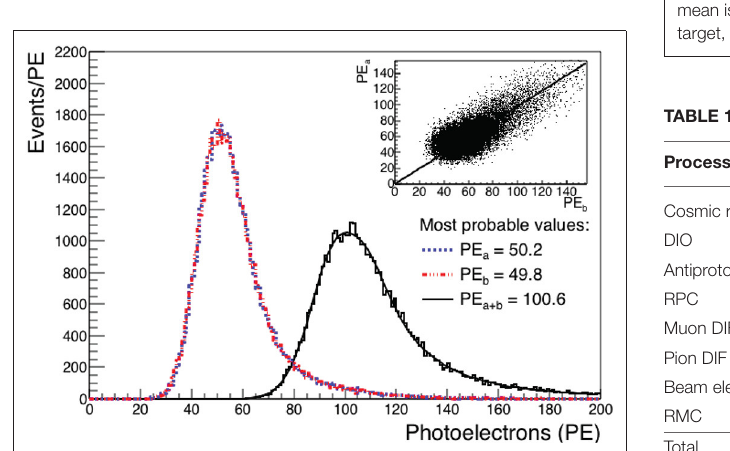
FIGURE 18 | Response in photoelectrons at a position 1 m from the SiPM readout for the reference counter read out with 2 × 2 mm 2 SiPMs. Dashed and dotted curves are the respective responses from each of the two SiPMs at one end of the counter, and the solid line is the sum of the responses. The distribution was fit to the sum of a Gaussian and a Landau function and the fit is also shown for the summed response. The inset shows the correlation between the two channels and the line from the correlation fit described in Artikov et al. [39]. Figure and caption text from Artikov et al. [39].